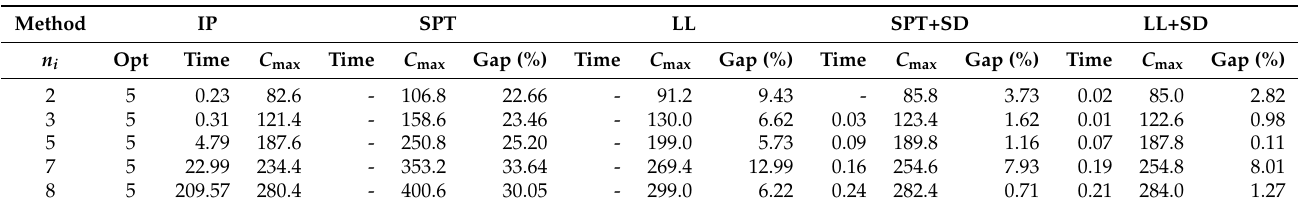
Table 2. Results for s i ∈ [ 1,10 ] and p i ∈ [ 1,50 ] .